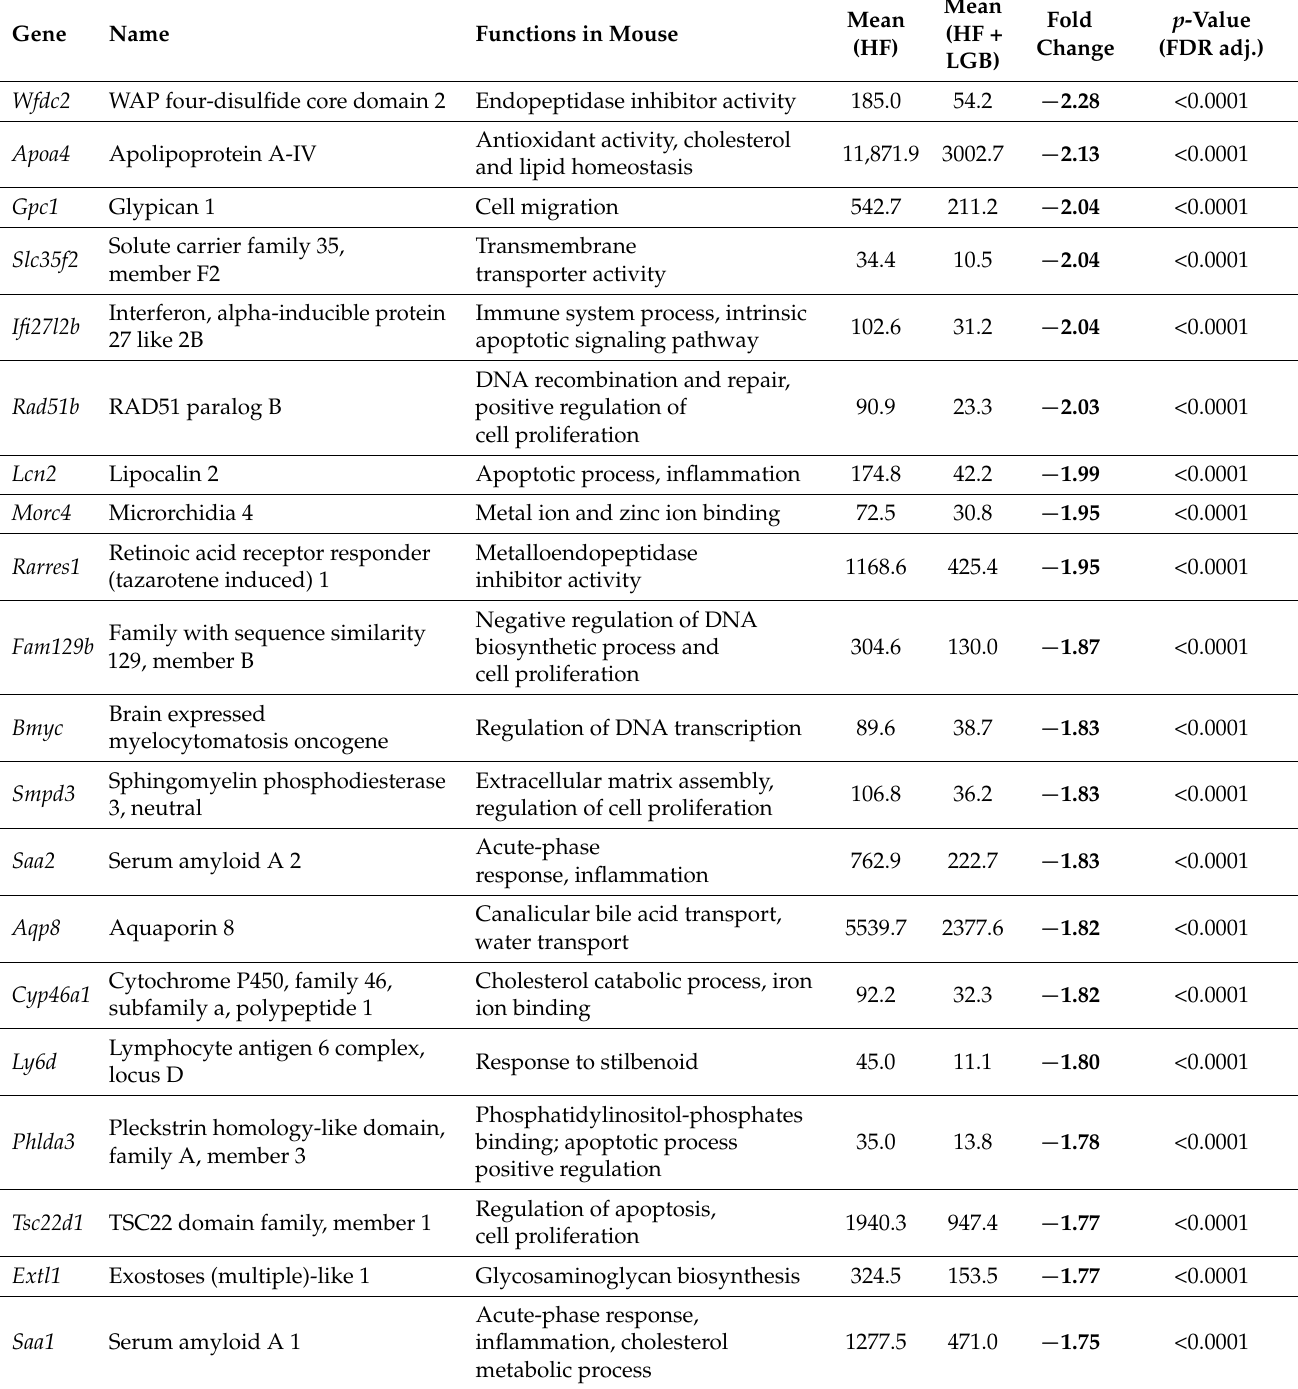
Table 3. The twenty genes with the largest negative fold change (FC) in the lingonberry supplemented high-fat diet (HF + LGB) group relative to the high-fat diet (HF) group. Mean expression levels are given as DESeq2-normalized counts. p -values are adjusted by false discovery rate